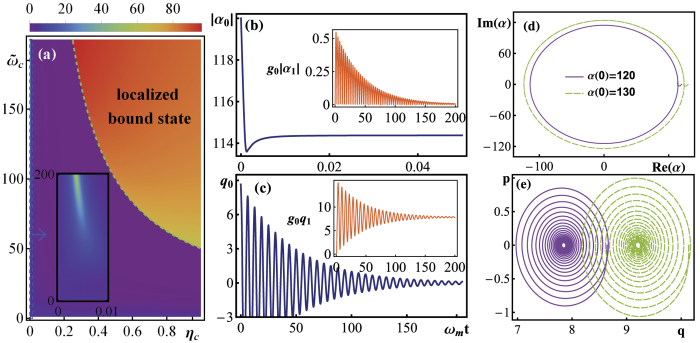
Classical dynamics in an optomechanical system, in units of ωm.(a) is the density plot of , in which we show the region in the parameter space of coupling ηc and frequency cutoff ωc, where significant bound state exist with E = 10ωm and Δc = 2 ωm. Plot (b–e) show the dynamical evolution of the classical variables, where g0 = 6 × 10−4ωm, ηm = 0.03, ωm = 11ωm and E = 0. The other parameters are ηc = 0.05, sc = 3, sm = 1,   = 11ωc = 1100ωm, α(0) = 120, p(0) = 0, and we keep .